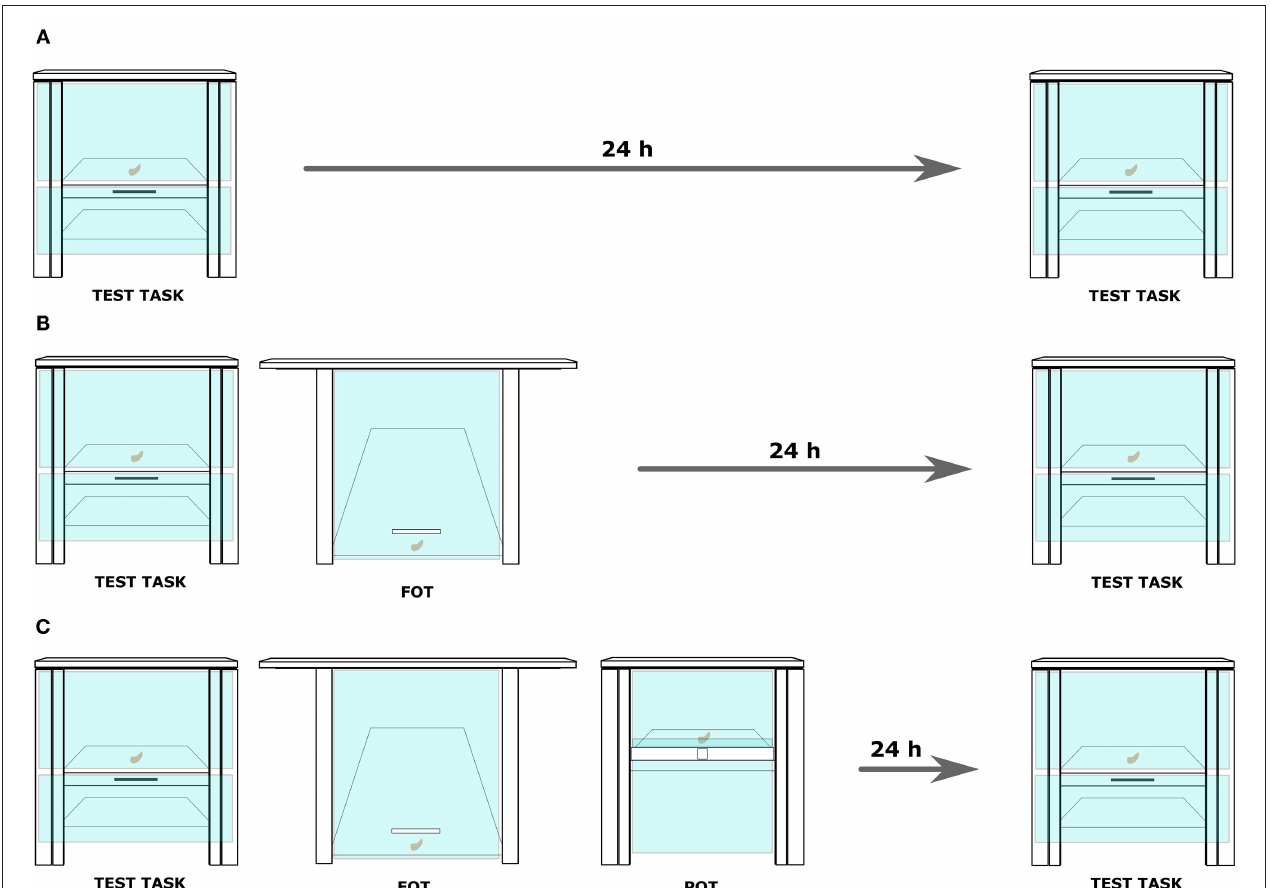
FIGURE 2 | A display of three conditions introduced in the experimental setup. (A) Control: the subject was exposed twice to the test task. A 24-hour delay, but no trainings were conducted between the two exposures. (B) No-conflict: after the first exposure to the target problem, the subject received training on a functionally overlapping task (FOT). After it reached the learning criterion, a 24-h delay commenced before the second exposure to the test. (C) Conflict: in this condition, the training on the FOT was immediately followed by a training on a perceptually overlapping task (the POT). Again, after the learning criterion was reached, a 24-h delay commenced before the second exposure to the